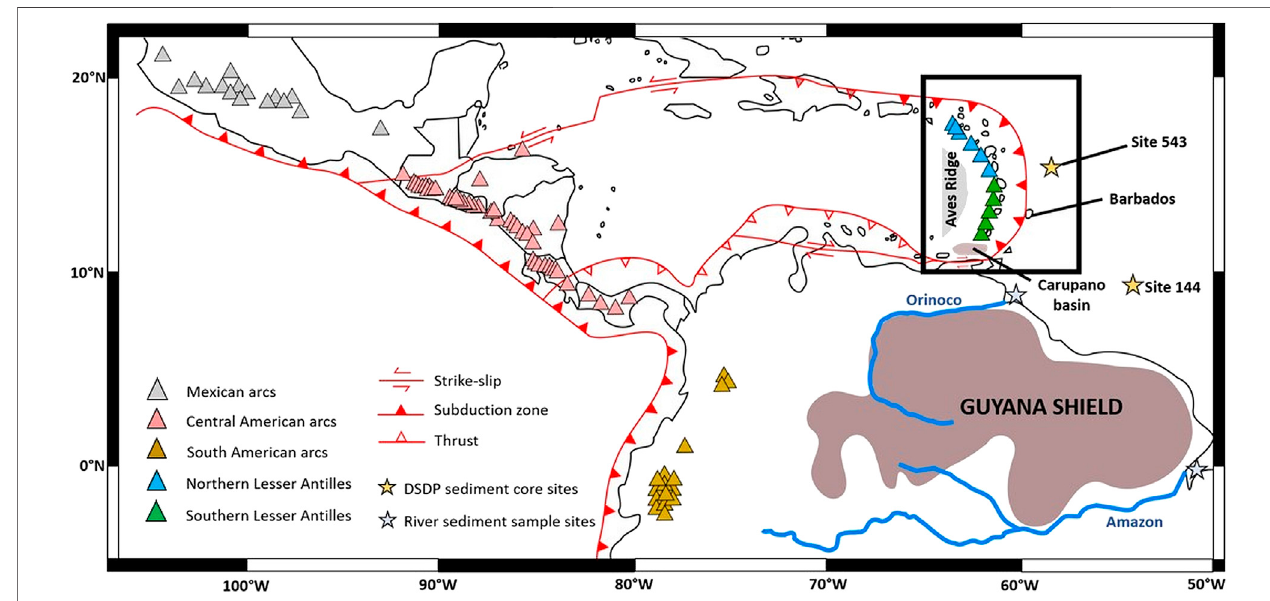
FIGURE 1 | Tectonic setting of Lesser Antilles arc (outlined by black box) and nearby arcs in Central-South America. The sampling sites of sediments discussed in Potential Sediment Sources are labeled. Locations of Site 543 and Site 144 from Carpentier et al. (2008). Locations for Orinoco and Amazon samples from Allegre et al. (1996); Parra et al. (1997) and Rousseau et al. (2019).